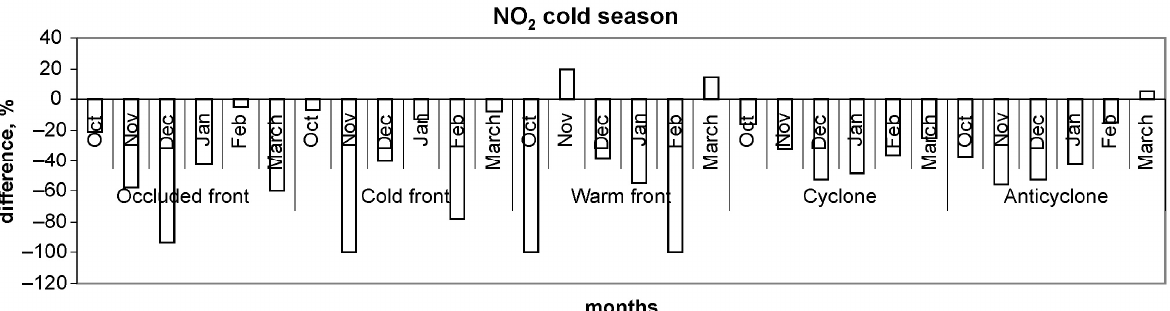
Fig 6. Difference between NO 2 three-year monthly average and average concentration during cold season at Preila background